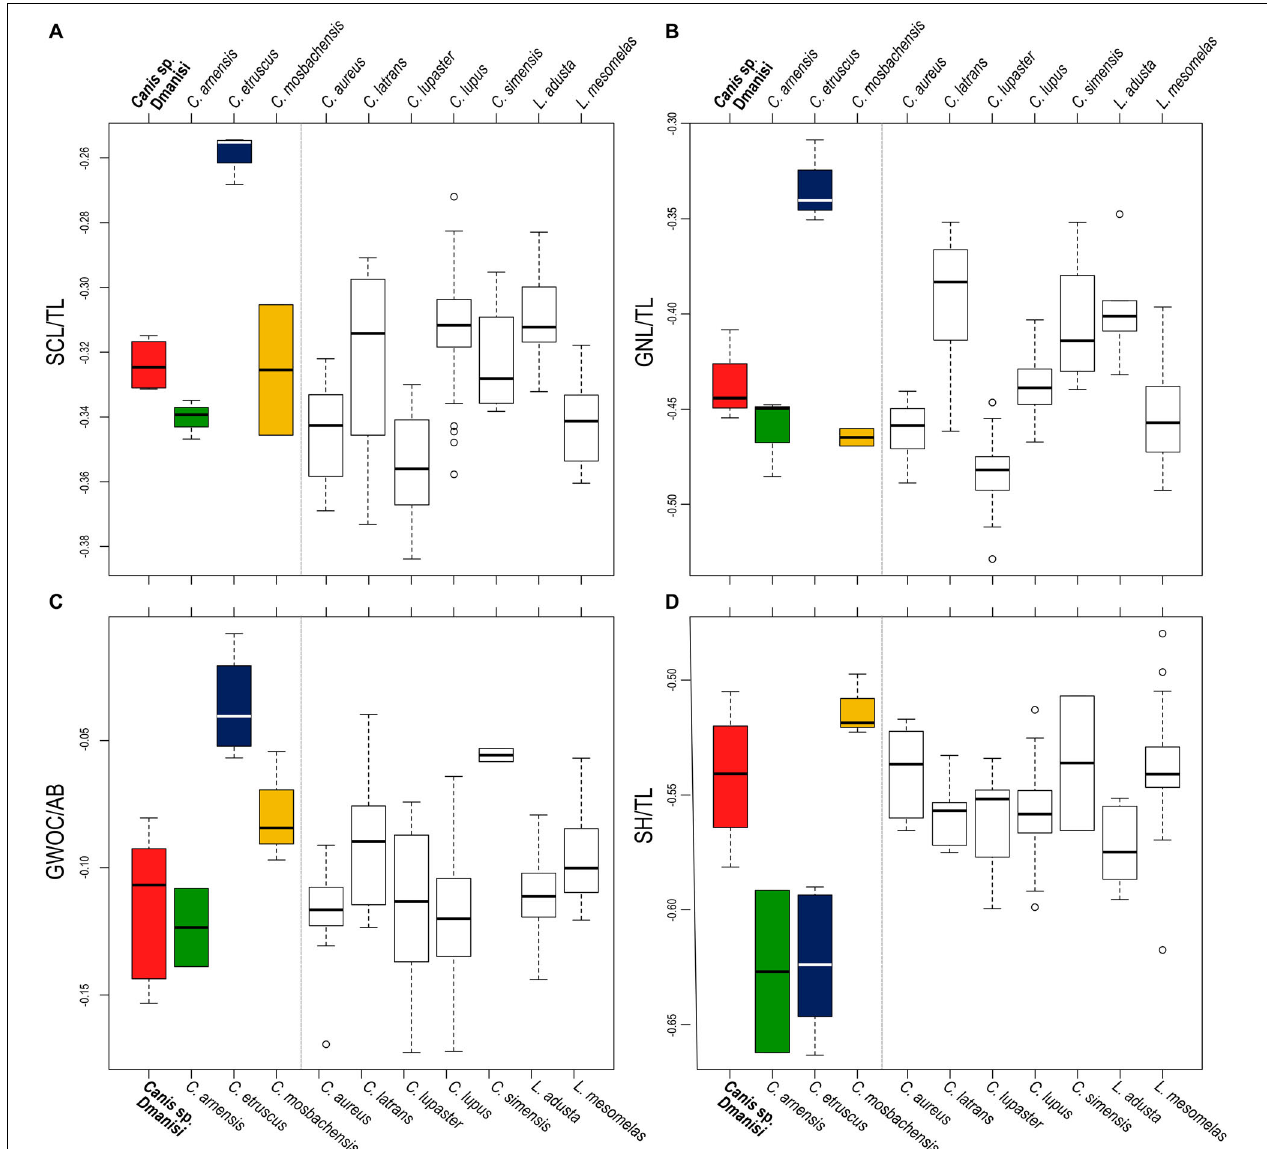
FIGURE 5 | Boxplots of selected cranial ratios: (A) relative length of the splanchnocranium, ScL/TL; (B) relative length of the nasals, GNL/TL; (C) width of the occipital condyles relative to the height of the cranium, GWOC/AB; (D) relative height of the cranium (including the sagittal crest), SH/TL. Gray dashed line separates the fossil species from the extant